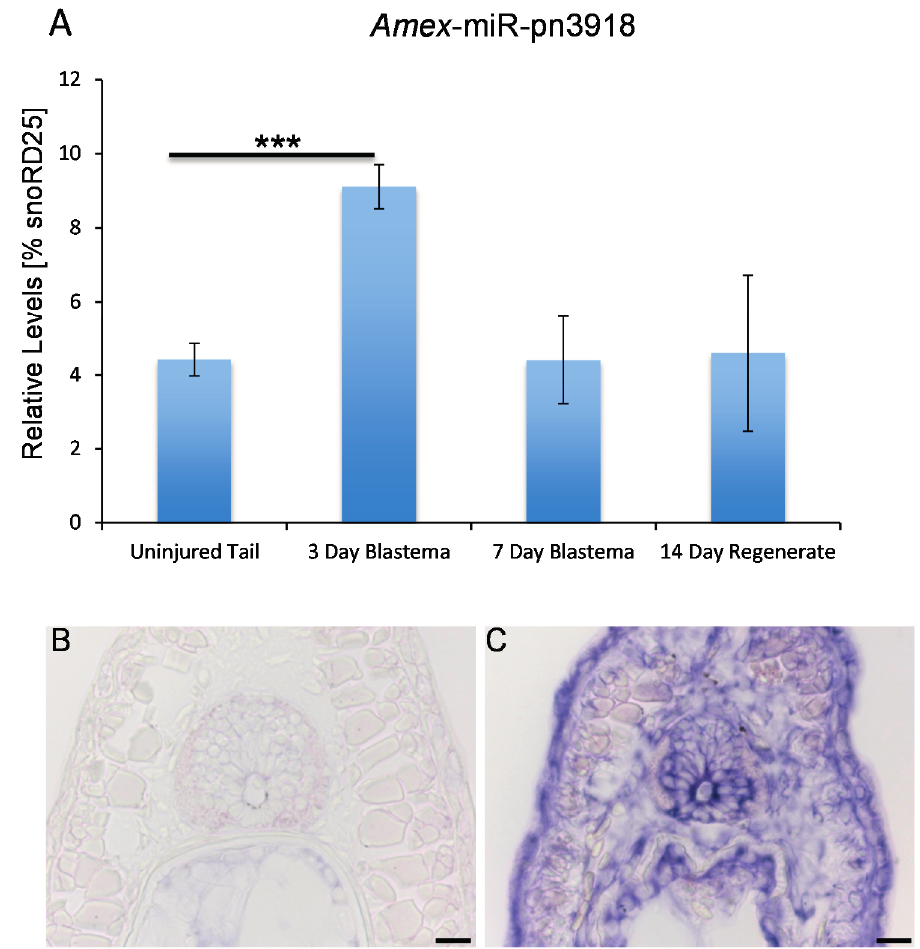
Figure 3. Amex -miR-pn3918 is upregulated in the tail blastema. ( A ) Quantitative RT-PCR analysis confirmed the deep sequencing data that Amex -miR-pn3918 is upregulated in the three day blastema and returns to basal levels by seven days post injury ( *** p < 0.001); ( B , C ) In situ hybridization shows that Amex -miR-pn3918 is upregulated in cells distal to the plane of amputation, ( B ) is a section proximal to the plane of amputation, no positive staining is observed; and ( C ) Is a section distal to the plane of amputation; skin, radial glial, and blastema cells show positive purple staining for Amex -miR-pn3918 probe, n = 10, Scale bar = 50